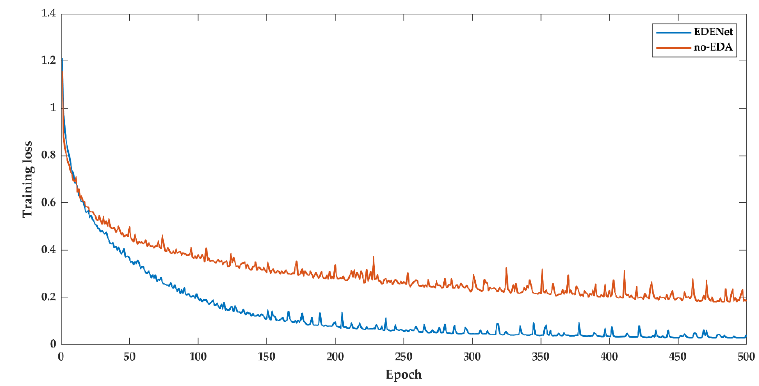
Figure A1. Training loss of Vaihingen dataset.